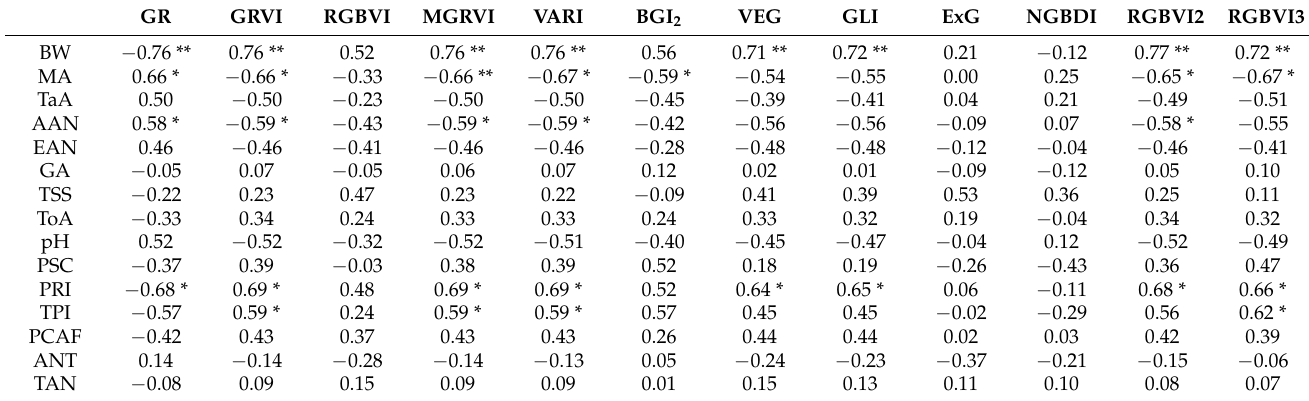
Table 4. Pearson linear correlations between 15 must quality variables and 12 vegetation